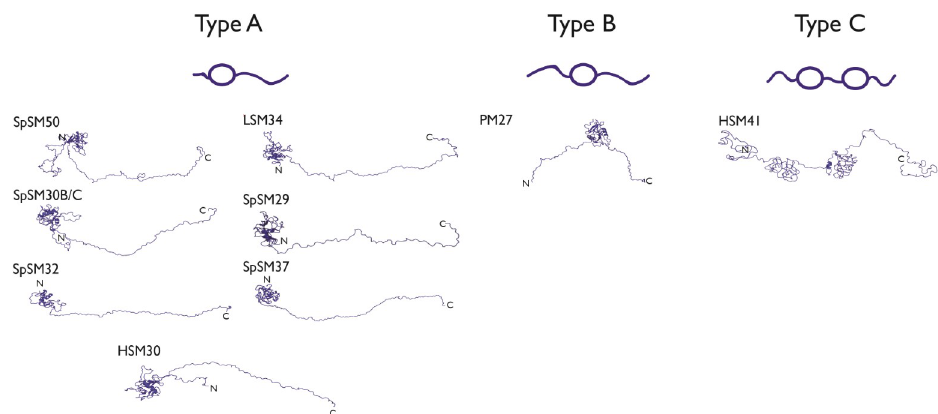
Fig 6. Categories of spicule matrix protein backbone conformations predicted by DISOclust/Intfold 4.0 (ribbon representation, lowest energy conformer) for nine sea urchin spicule matrix proteins (Table 1). Under each Type is a cartoon representation of global conformation (circle = folded conformation; squiggle line = disordered conformation). Best template model for the globular domain, confidence levels, P scores, and global model quality scores can be found in Table 2. N- and C-terminal ends are denoted.